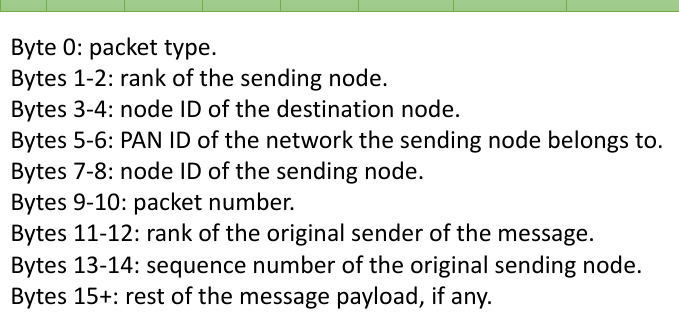
Figure 6. Extreme-LT header frame